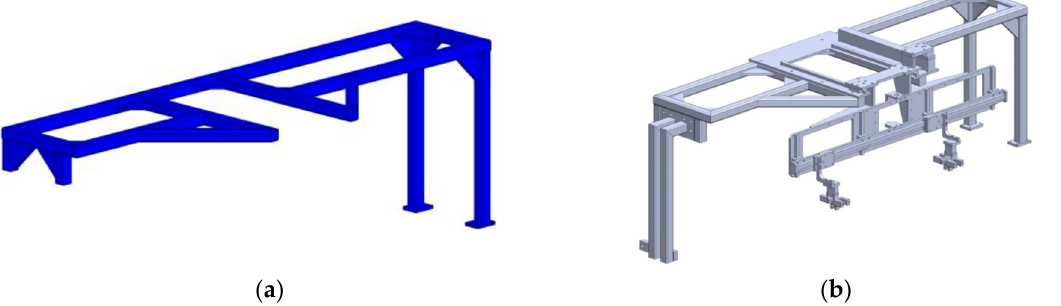
Figure 13. Modified structure for the robotic manipulator: ( a ) standalone structure, ( b ) assembled